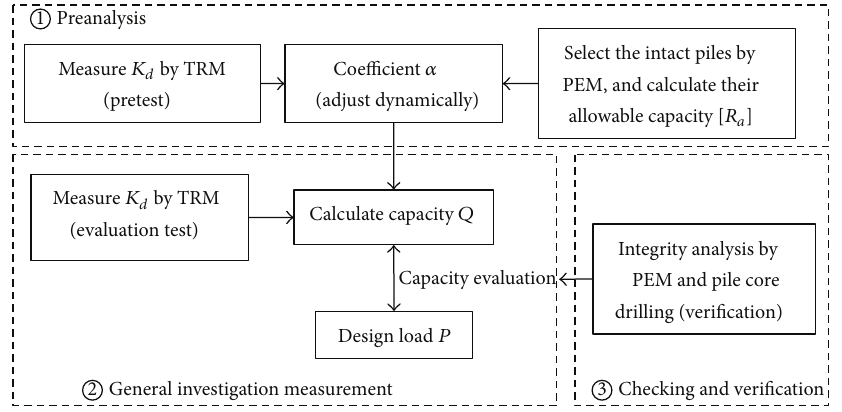
Figure 2: Flowchart of the bridge pile evaluation and analysis.